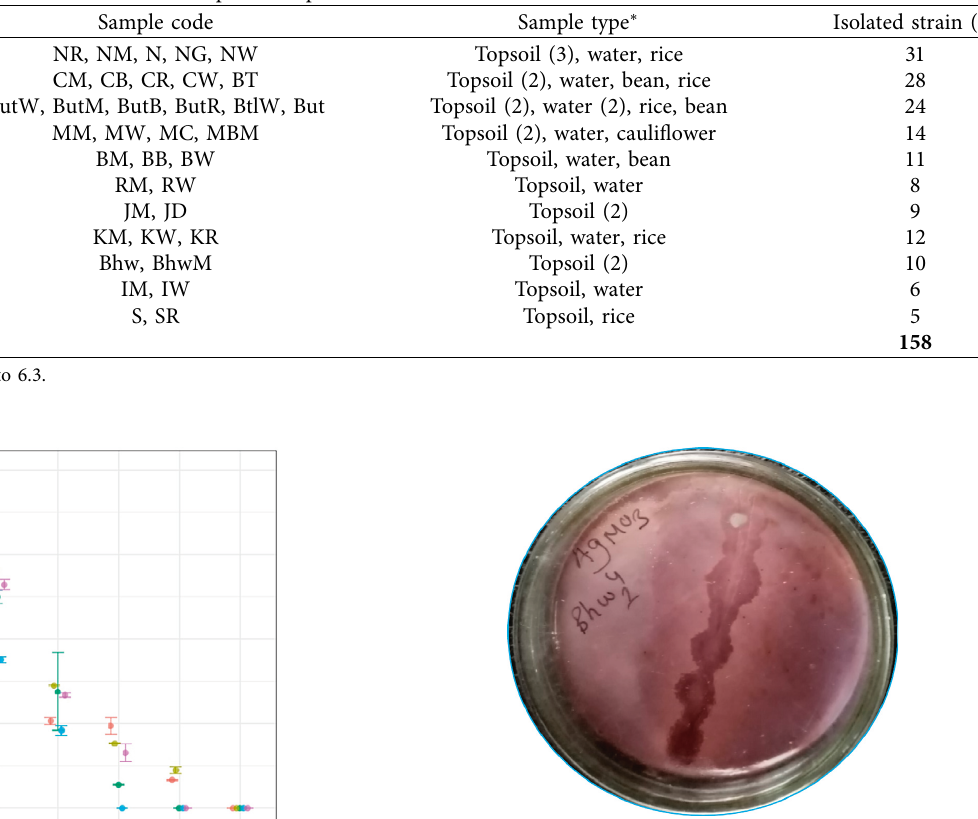
Figure 2: Silver nitrate test of isolate Bhw1-4 after incubation for 3 days at 37 ° C in NA containing 600ppm sodium arsenite.